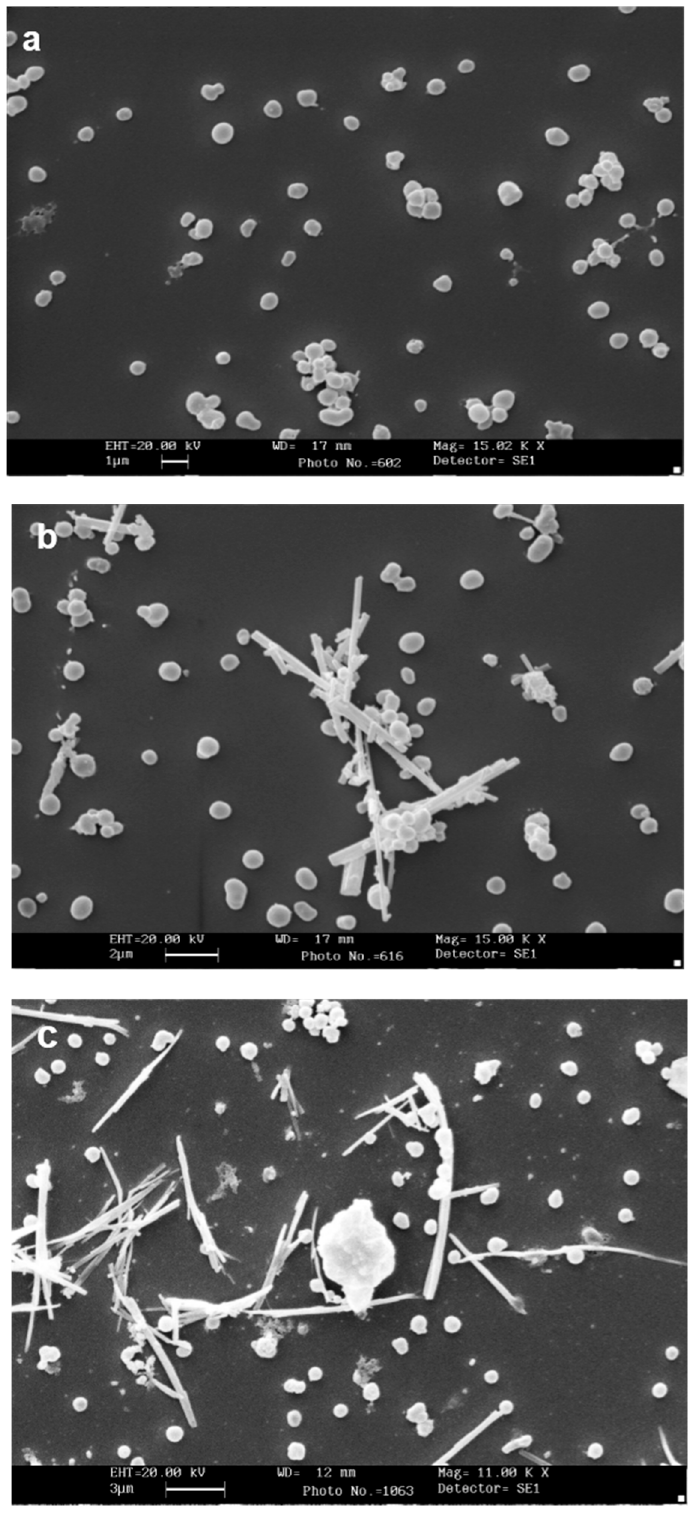
Figure 3. Interaction of RPMC-isolated granules with crocidolite as observed by SEM. ( a ) Isolated membrane-covered granules alone; ( b ) isolated membrane-covered granules incubated with 100 µ g/mL of crocidolite fibers; ( c ) isolated membrane-covered granules incubated with 100 µ g/mL of TiO 2 NWs. A fiber-bound cluster of granules can be seen. Magnification: bars in ( a ) = 1 µ m; ( b ) = 2 µ m; ( c ) = 3 µ m.